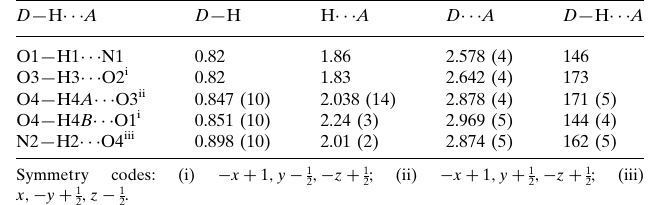
Hydrogen-bond geometry (A˚ , (cid:2) ). D —H (cid:1)(cid:1)(cid:1)